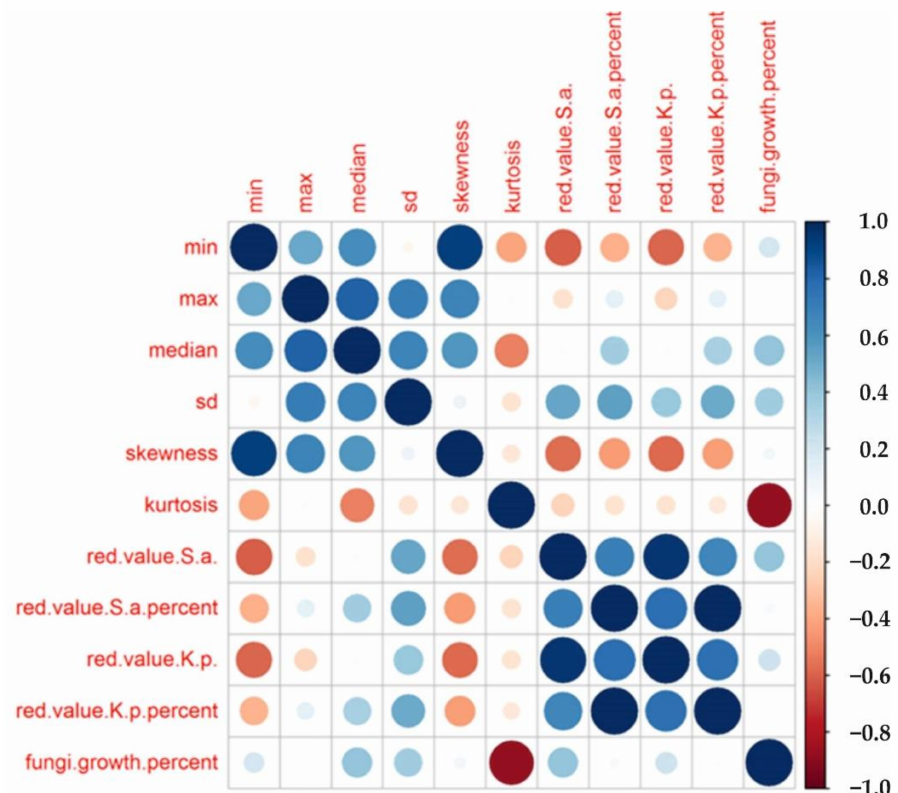
Figure 6. Correlation matrix between morphological features and biocide properties of the investigated nonwoven samples. (min = minimum, max = maximum, sd = standard deviation, red. value = reduction values of Staphylococcus aureus ( S.a .) and Klebsiella pneumoniae [ K.p